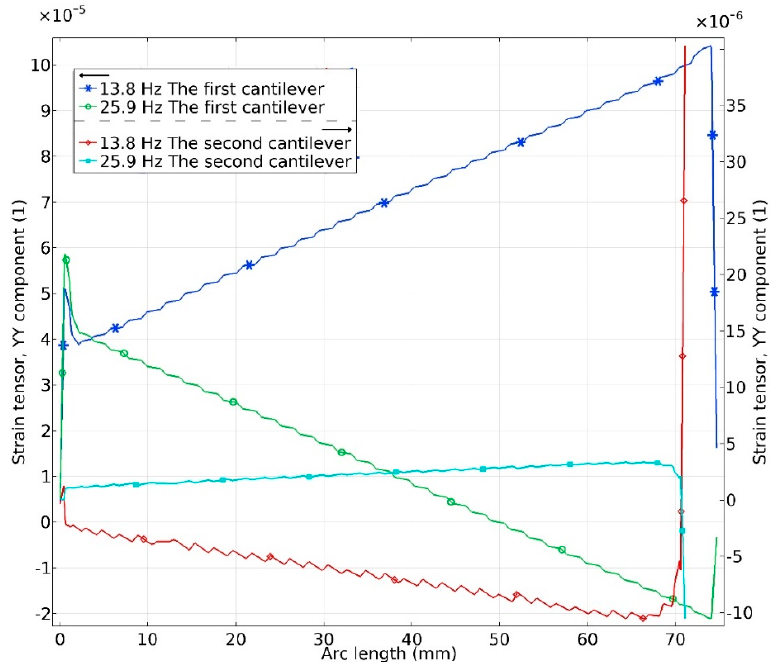
Figure 10. Bending strain characteristics at resonant frequencies during base excitation in y direction.